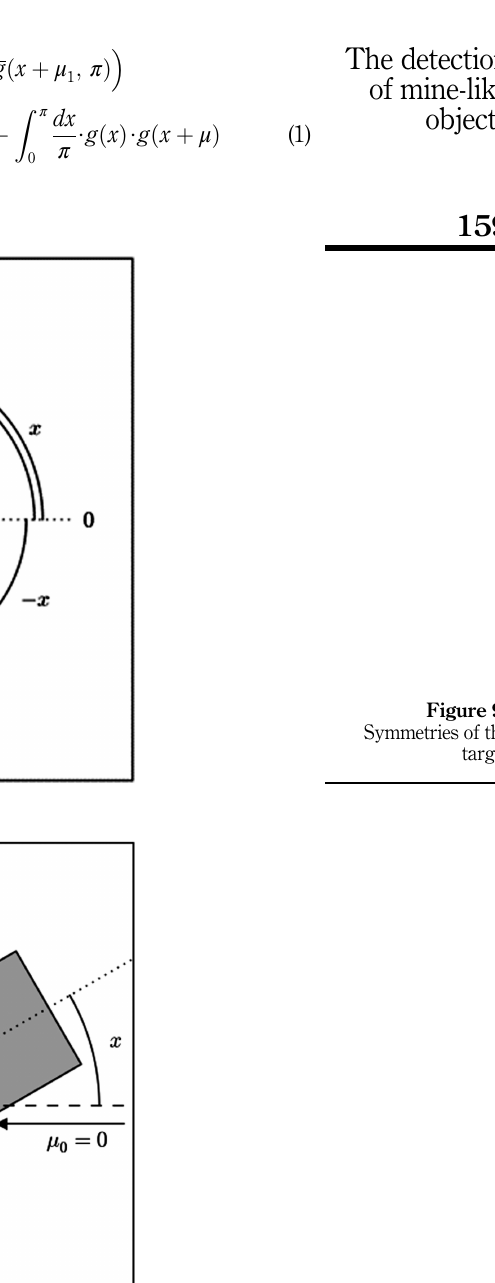
Figure 10. An example of two looks